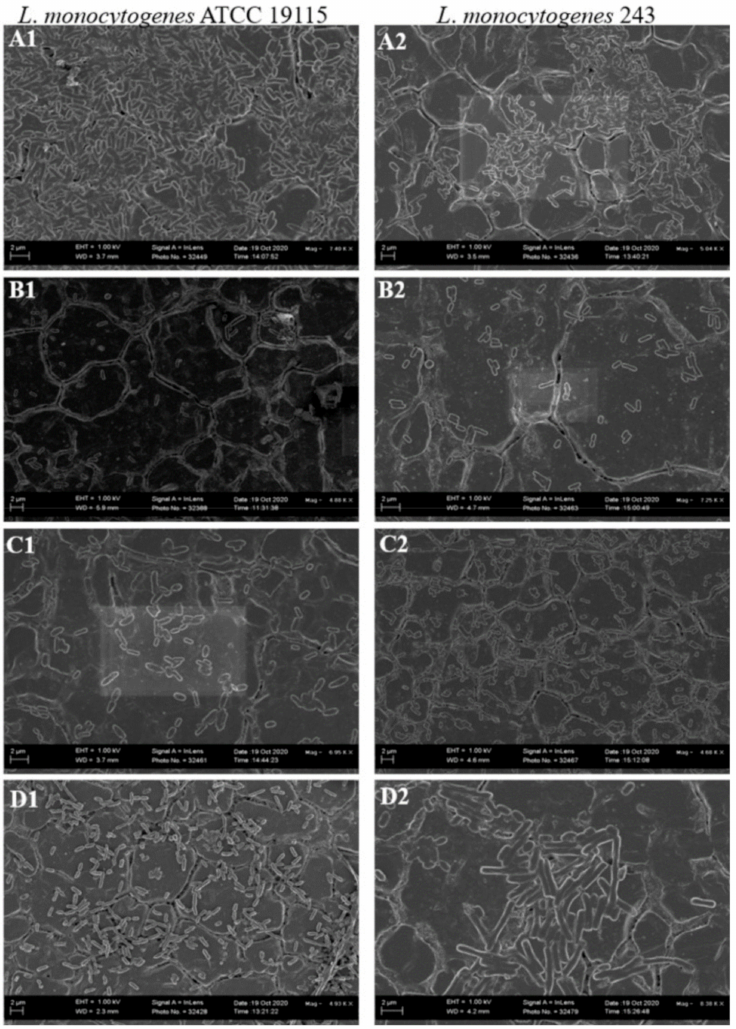
Figure 4. Scanning electron microscopy images of L. monocytogenes ATCC 19115 and L. monocytogenes 243 biofilms on stainless steel coupons after 7 days of incubation in TSB at 25 ◦ C ( A ), control;